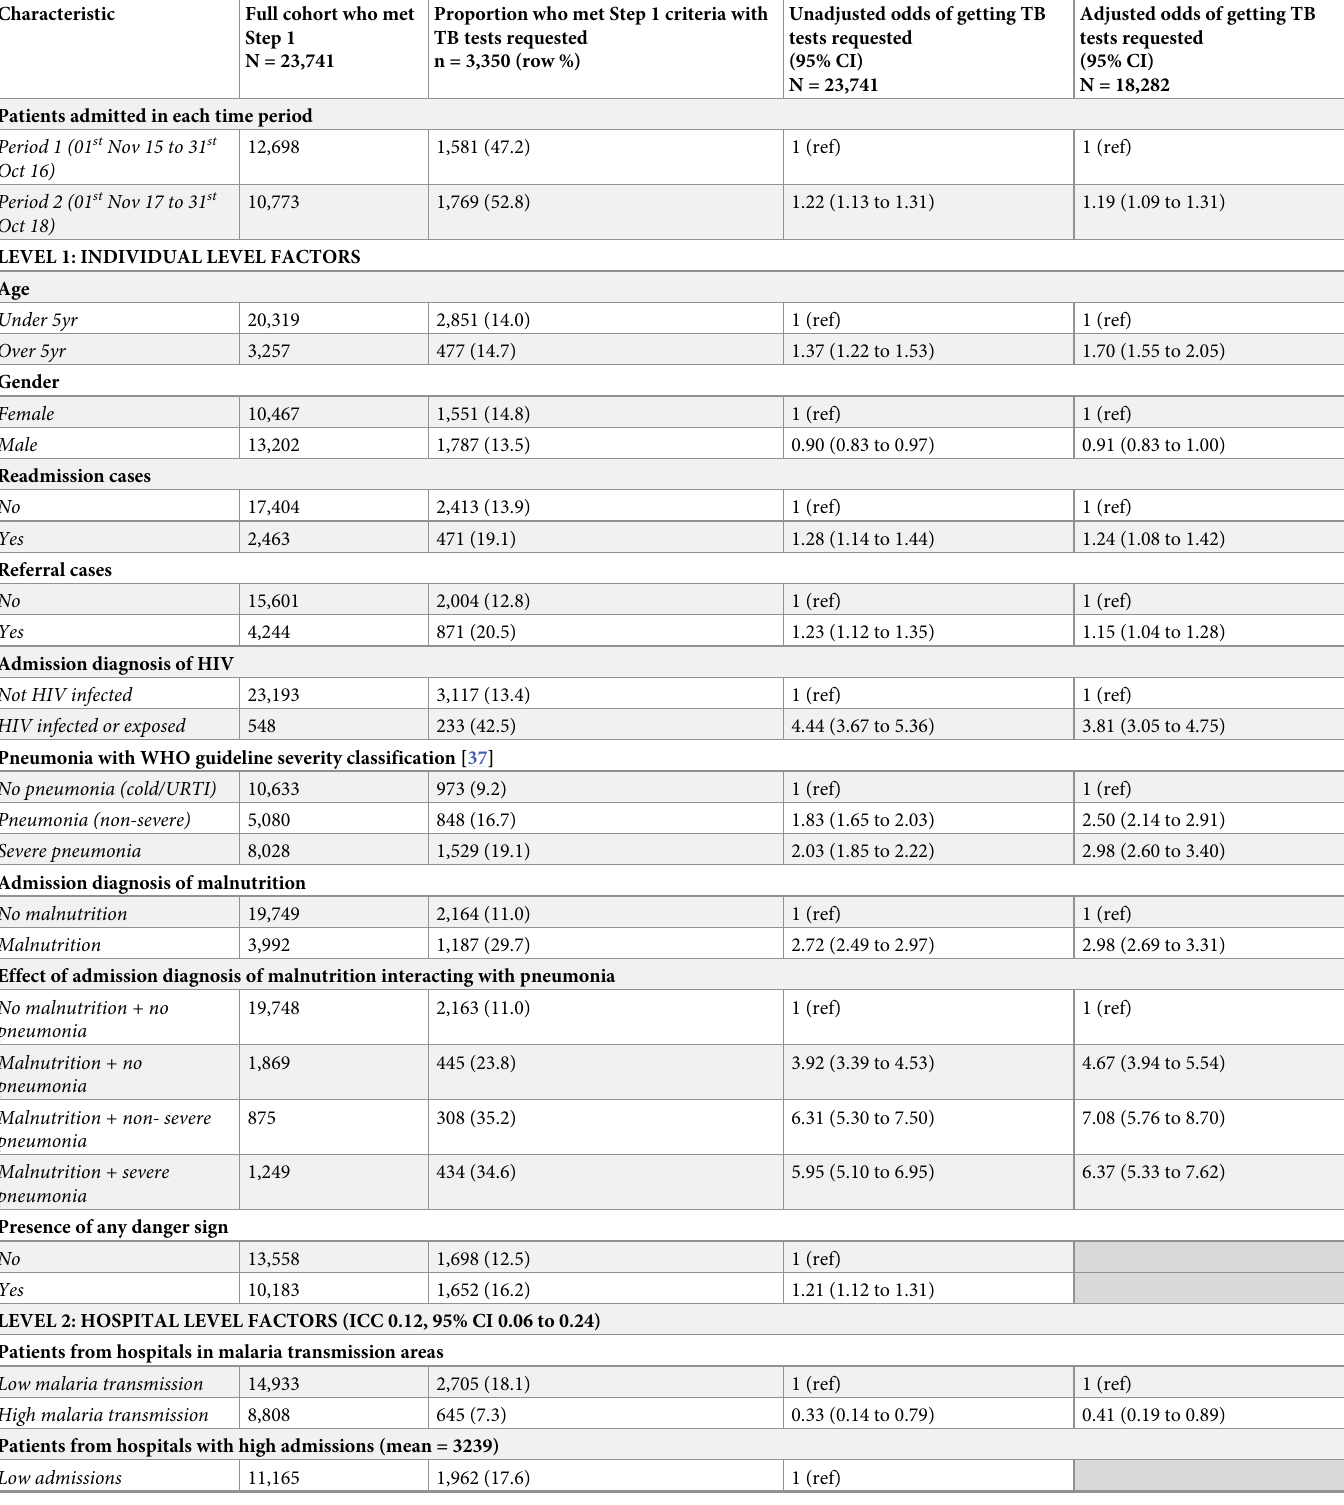
Table 3. Factors associated with TB tests in patients having two or more suggestive signs of